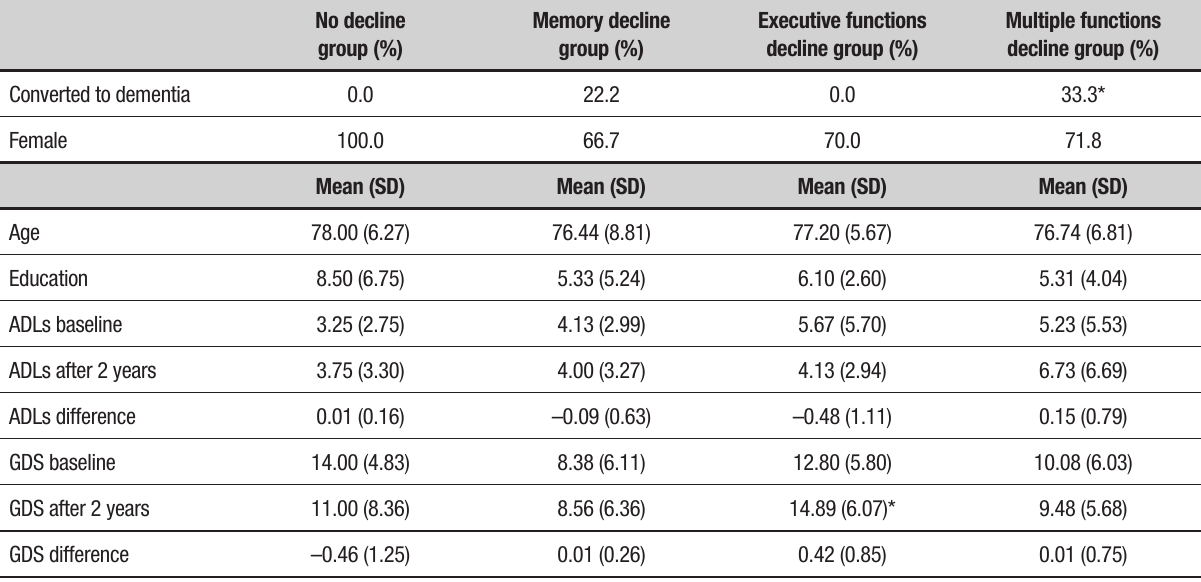
Table 3. Rate of conversion to dementia and sociodemographic, functioning and depression symptom characteristics of the four cognitive decline